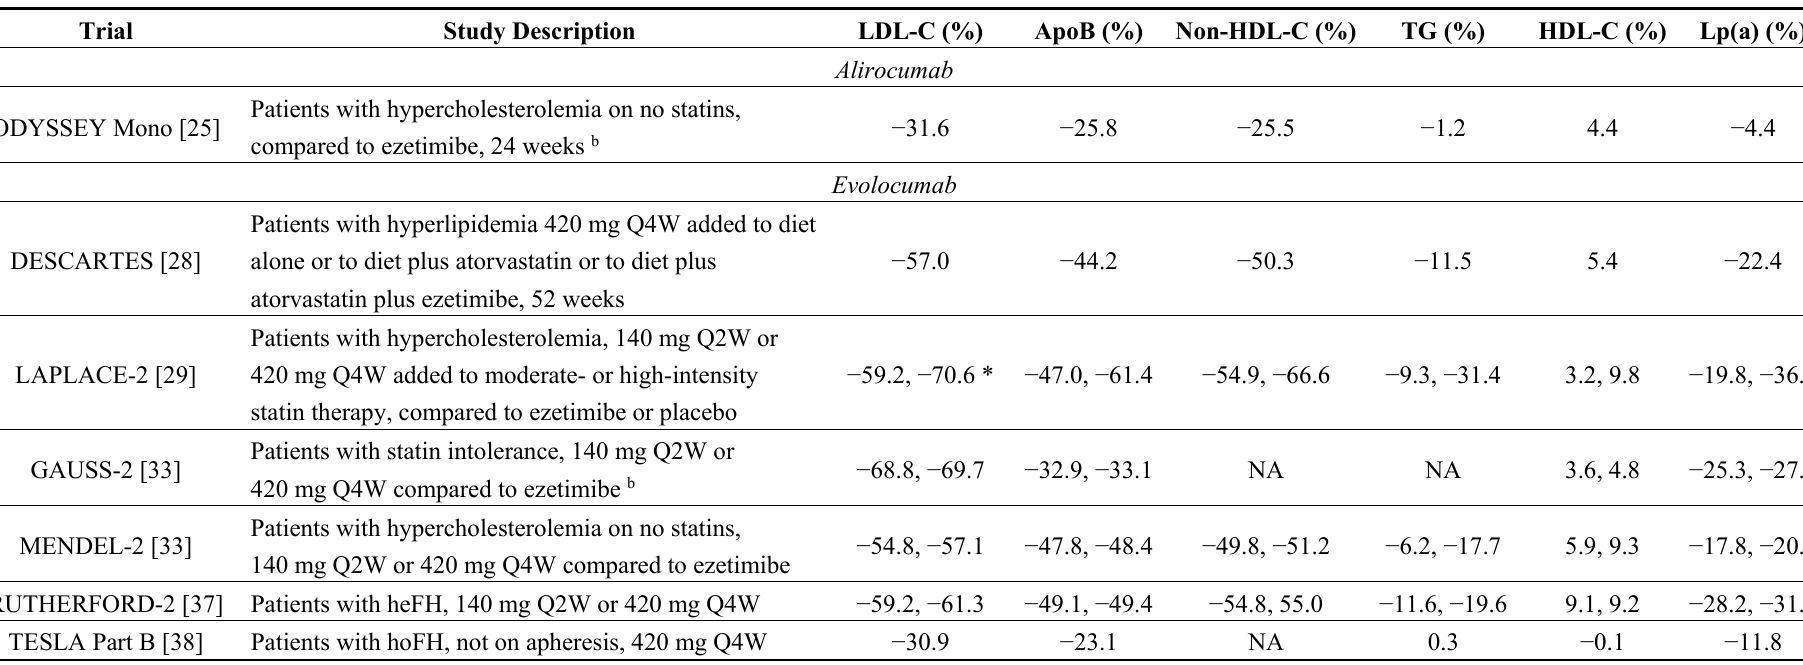
Table 1. Efficacy of alirocumab (75 mg Q2W) and evolocumab (140 mg Q2W or 420 mg Q4W) on plasma lipids and lipoprotein concentrations: data from phase 3 clinical trials a